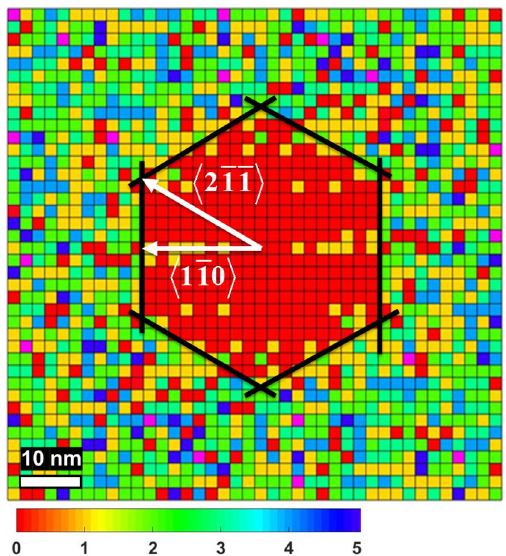
Figure 4. Island-island distance distribution histogram showing the spatial neighbor distribution of GaAs islands for the sample T1 (80 × 80 nm 2 ). The bin value color code is indicated.